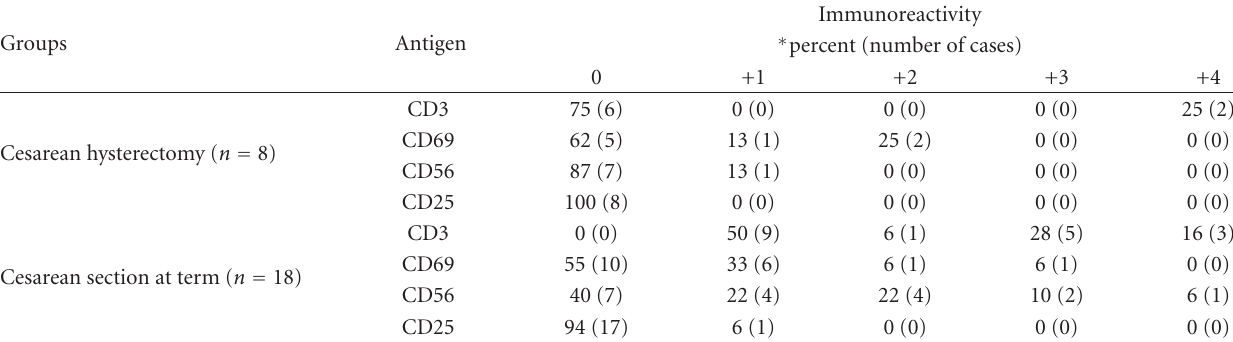
Table 2: Immunoreactivity of CD3, CD56, CD69, and CD25 antigens within decidua from patients who underwent cesarean section at term and those who underwent an emergency cesarean